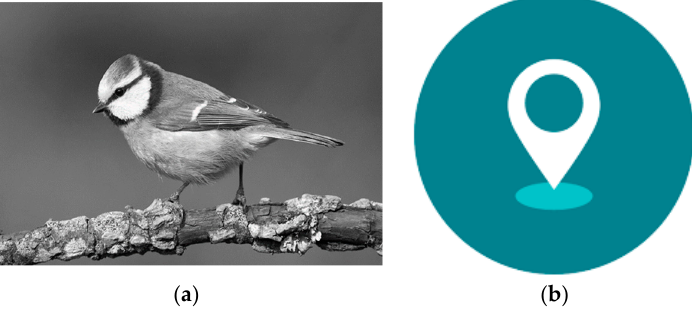
Figure 8. Experiment images. ( a ) PNG image with size 205 KB; ( b ) PNG image with size 3.22 KB.